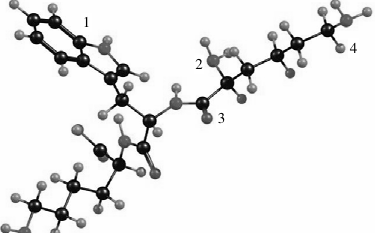
Figure 1. Structure of lysine-tryptophan-lysine (Lys-Trp-Lys) (Black (1) – Carbon, Pink (2)- Nitrogen, Red (3) – Oxygen, Blue (4)– hydrogen)